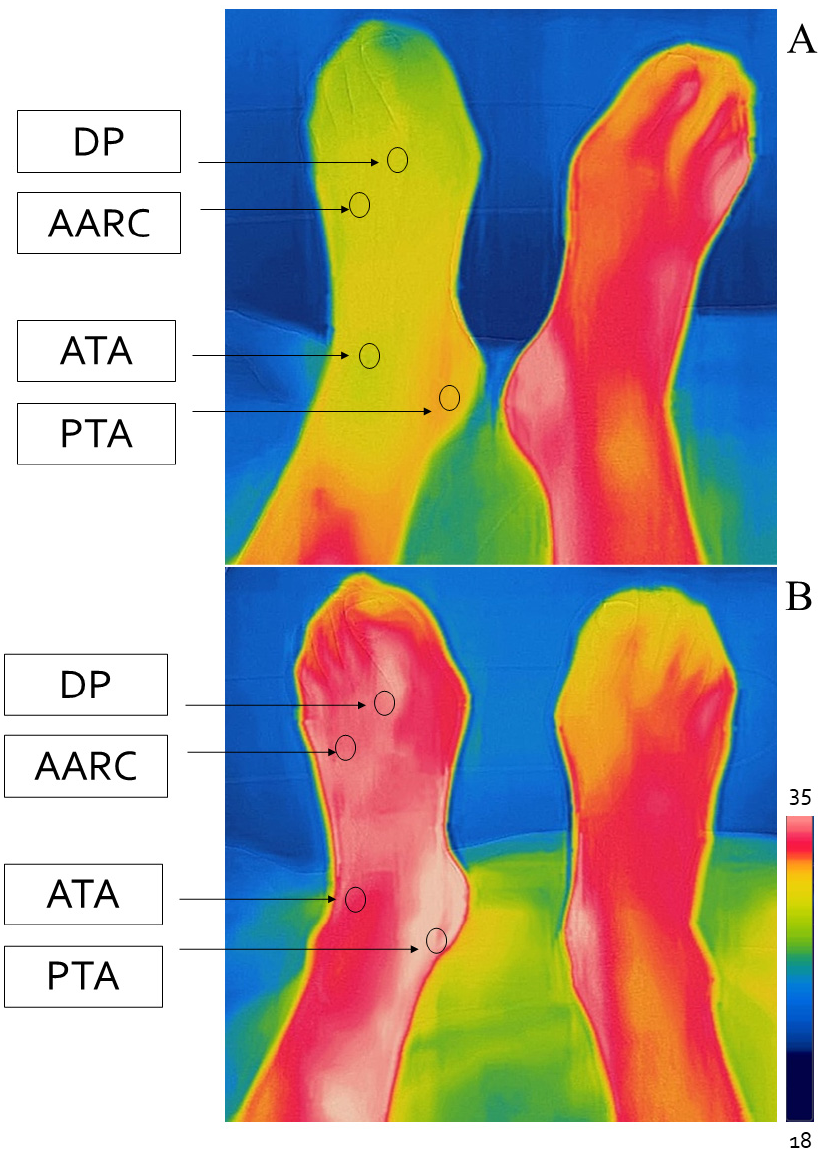
Figure 1. Sampling points of the foot temperature with infrared camera before ( A ) and after ( B ) revascularisation. DP: dorsalis pedis, AARC: arcuate artery, ATA: anterior tibial artery, PTA: posterior tibial artery. The scale ranges from 18 to 35 °C.